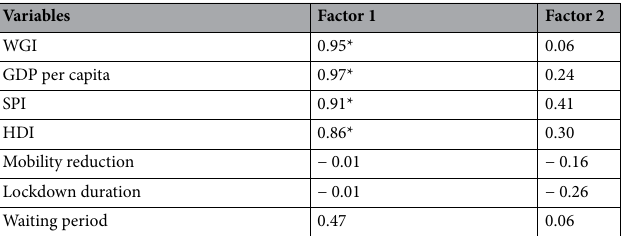
Table 2. Major extracted factors and associated loadings of waiting period and the potential drivers. WGI world governance indicator; GDP gross domestic product; SPI social progress index; HDI human development index. WP was set to zero for the unsuccessful countries. *Denotes dominant loadings for each